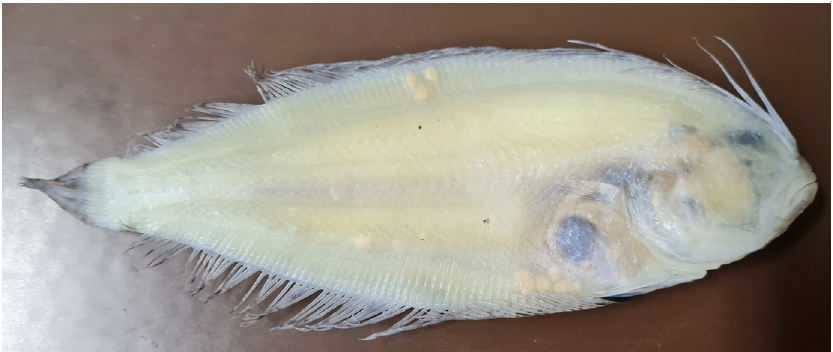
Fig. 7. – Arnoglossus imperialis Rafinesque, 1810, SMNS 27397, male, 118.7 mm SL, neotype of Bothus imperialis Rafinesque, 1810, Bothus punctatus Rafinesque, 1814 and Charybdia rhomdoidichthys Facciolà, 1885, Balearic Islands, northeast of Ibiza. Photograph of preserved specimen. Blind side.